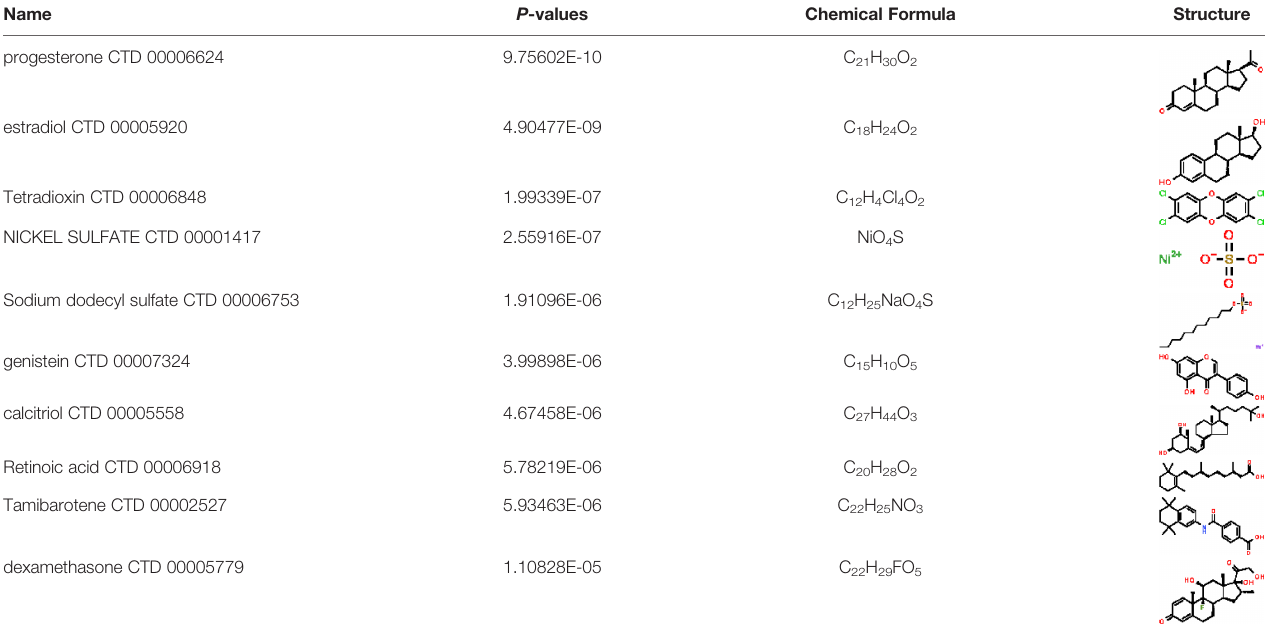
TABLE 4 | The recommended drugs for